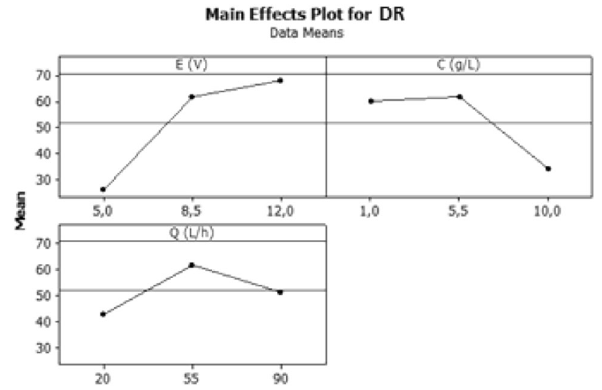
Fig. 6 Interaction effects plot for DR